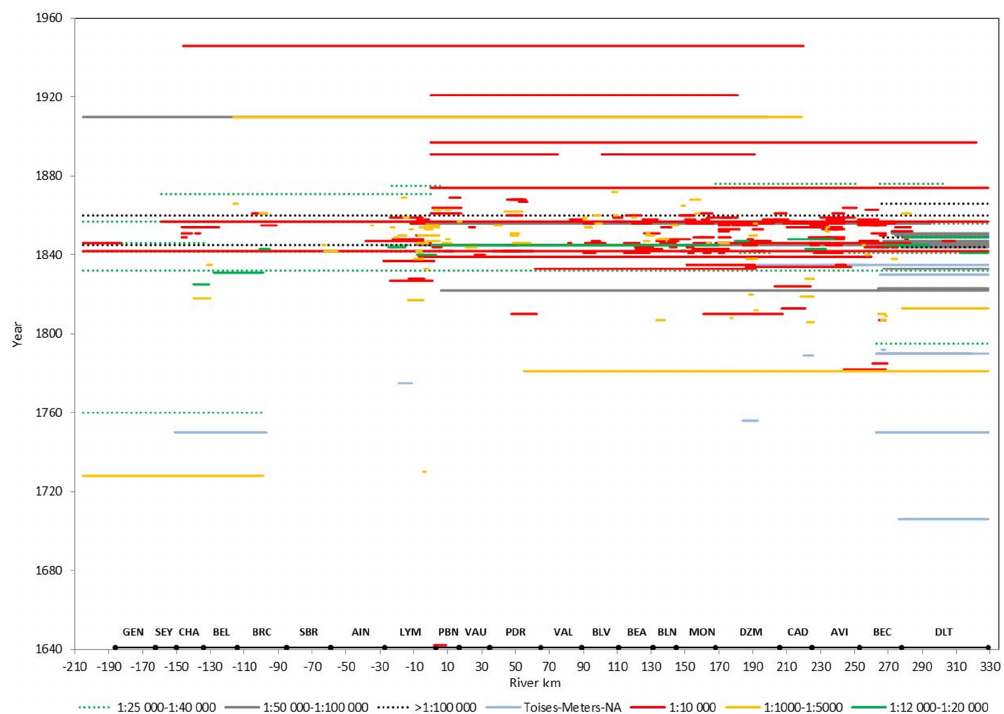
Figure 7. Longitudinal coverage and spatial scales of the cartographic dataset. The spatial extent of present river reaches is superimposed on the x axis (see Fig. 1 for acronyms).